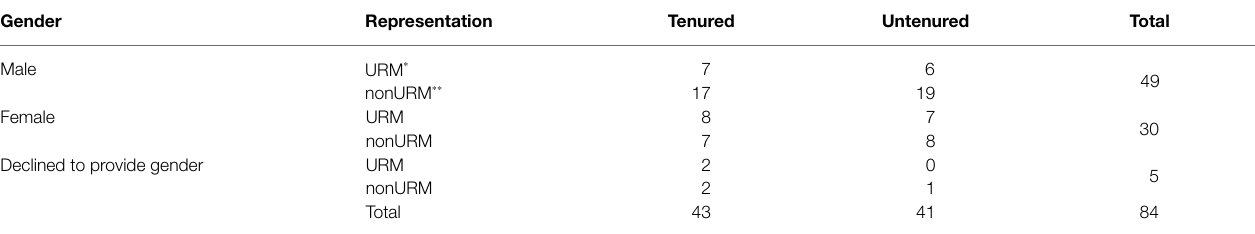
TABLE 1 | Demographic information of the participant